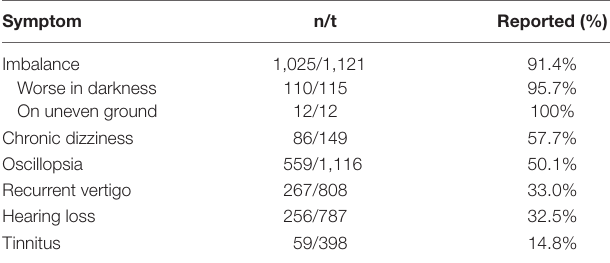
taBLe 1 | Nature and frequency of most common symptoms reported by patients with bilateral vestibulopathy in clinical